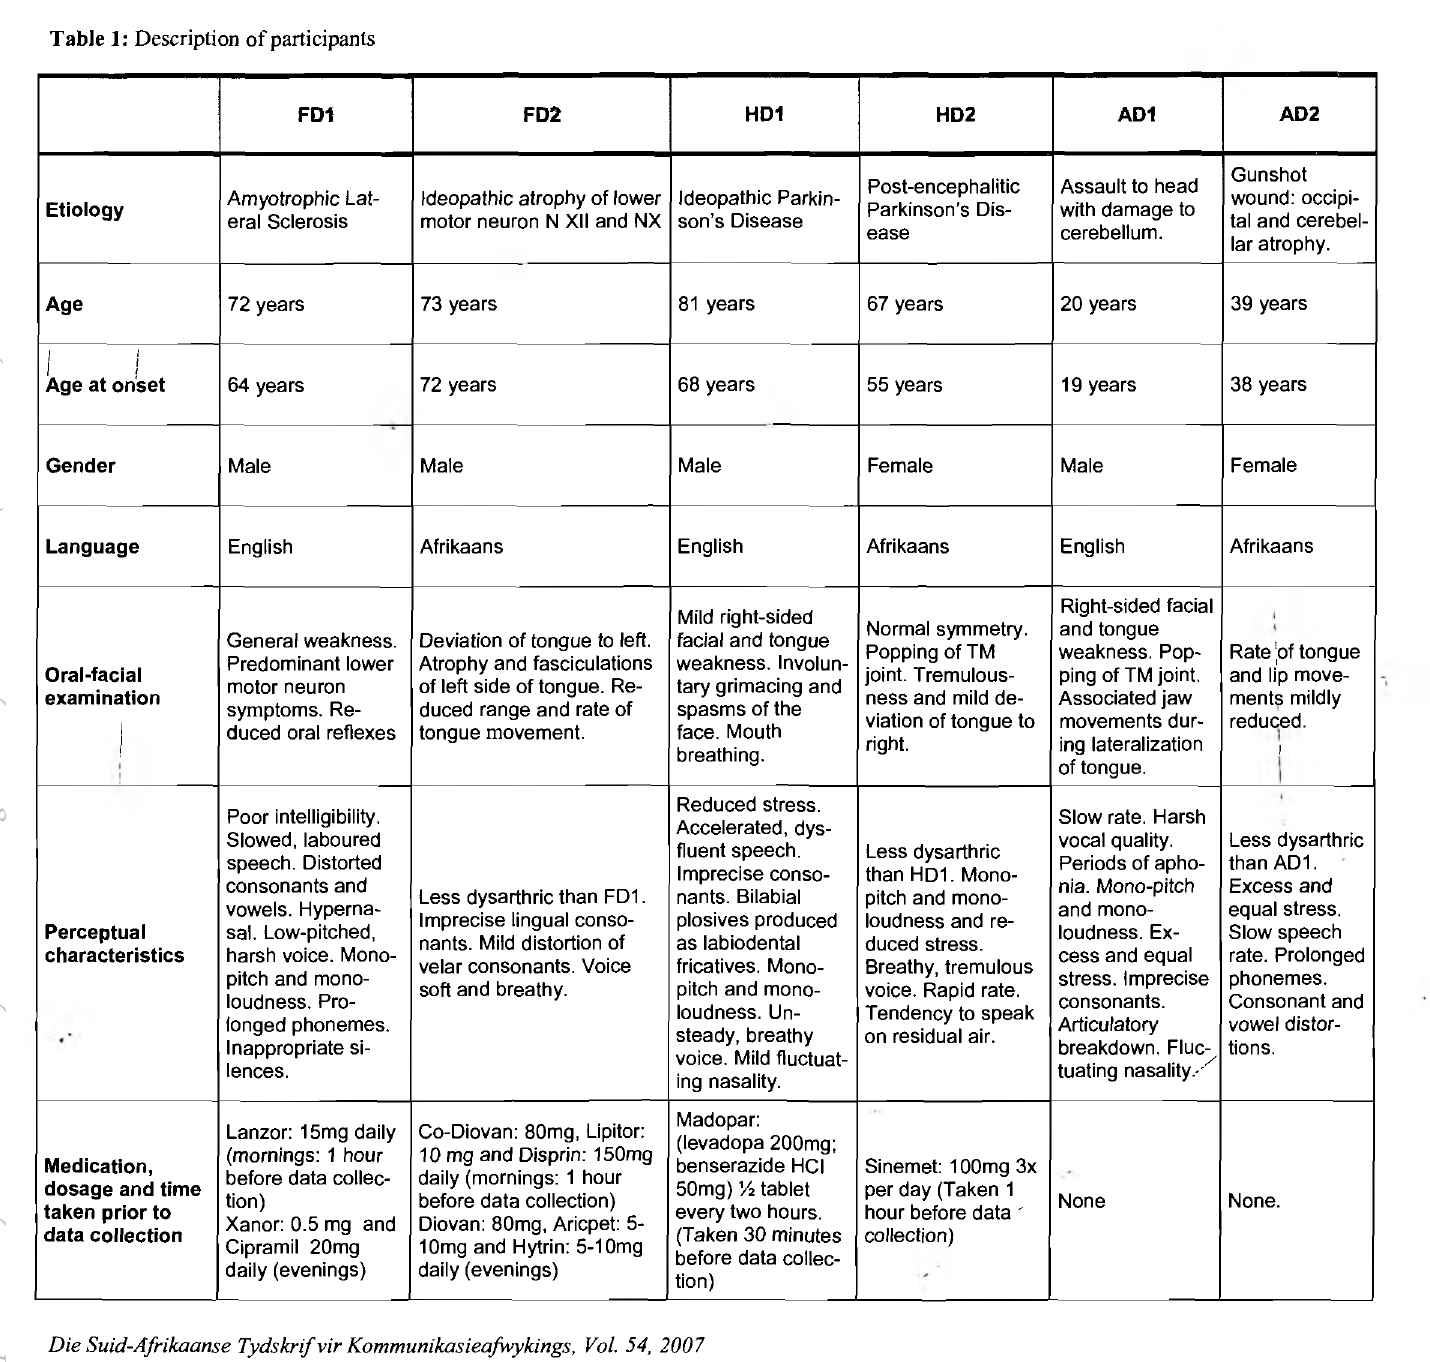
Table 1: Description of